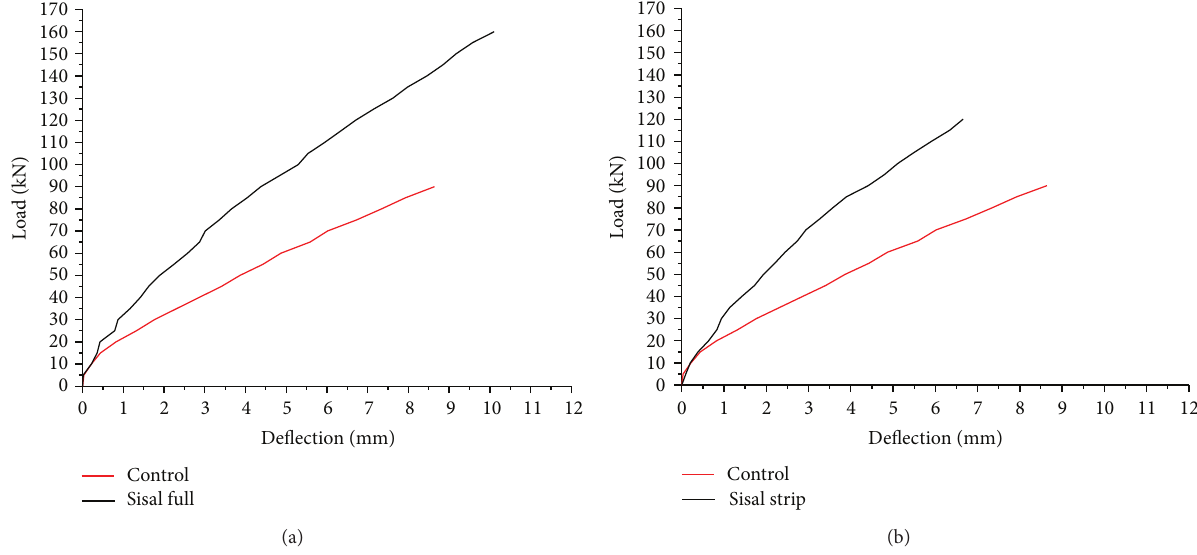
Figure 9: (a) load versus average midspan deflection of Groups A and B beams; (b) load versus average midspan deflection of Groups A and C